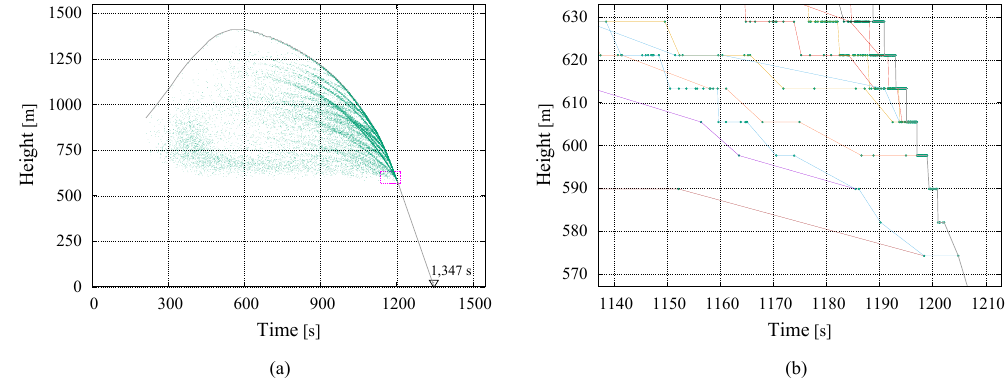
Figure 7. Collision events associated with a first surface raindrop. (a) All the associated collision events are plotted as dots, while the trajectory of the “mother” particle is shown as a line. (b) The enlarged view of the rectangular window shown in (a) . The trajectories of raindrops ( r p > 40µm) on a vertical resolution with 7.81m intervals. Each dot represents the individual collision events associated with the raindrops shown in colored